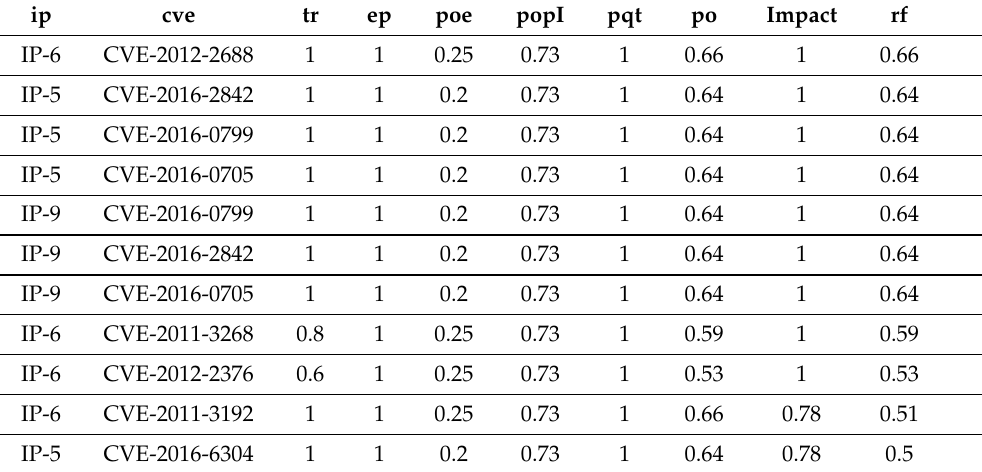
Table 4. Prioritization table: Extract of 11 vulnerabilities with calculated values shown through the prioritization table in the